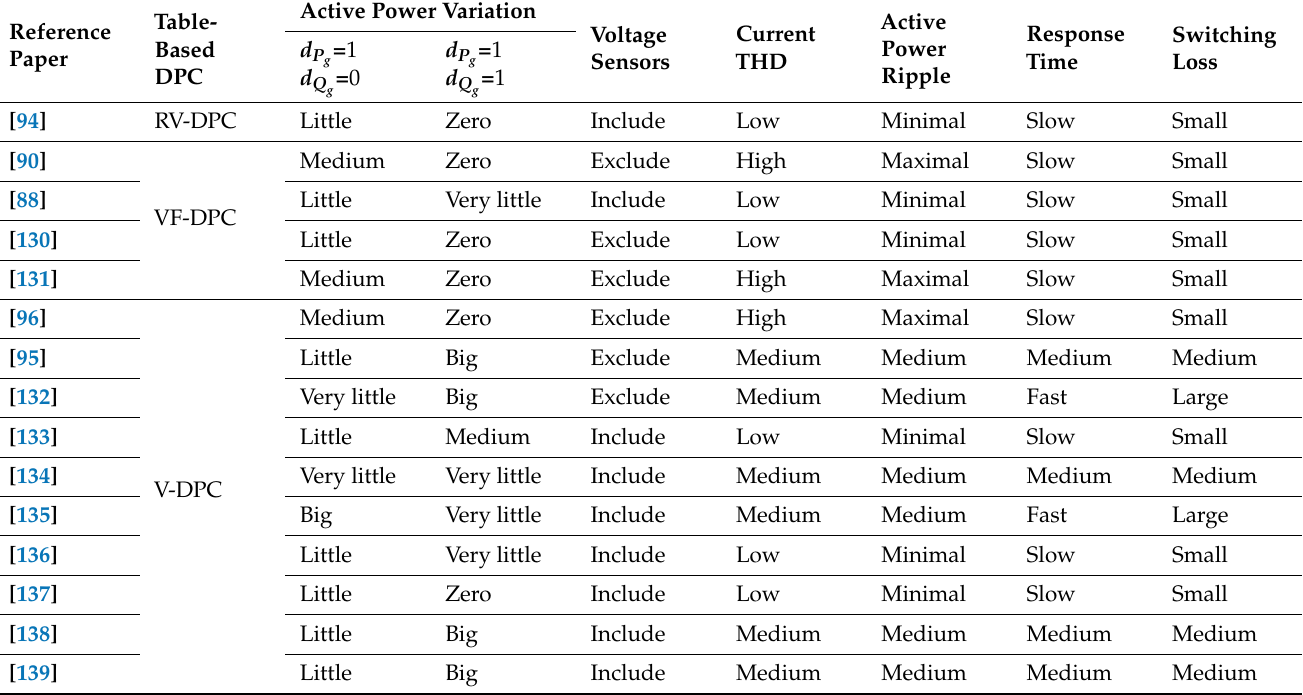
Table 6. Comparison between different employed table-based DPC techniques. Active Power